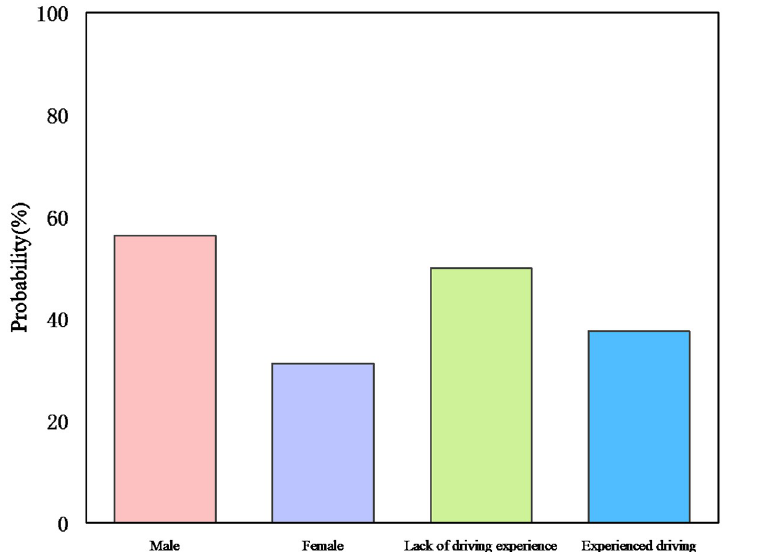
Fig 7. Effect of driving demographics on the probability of passing a yellow